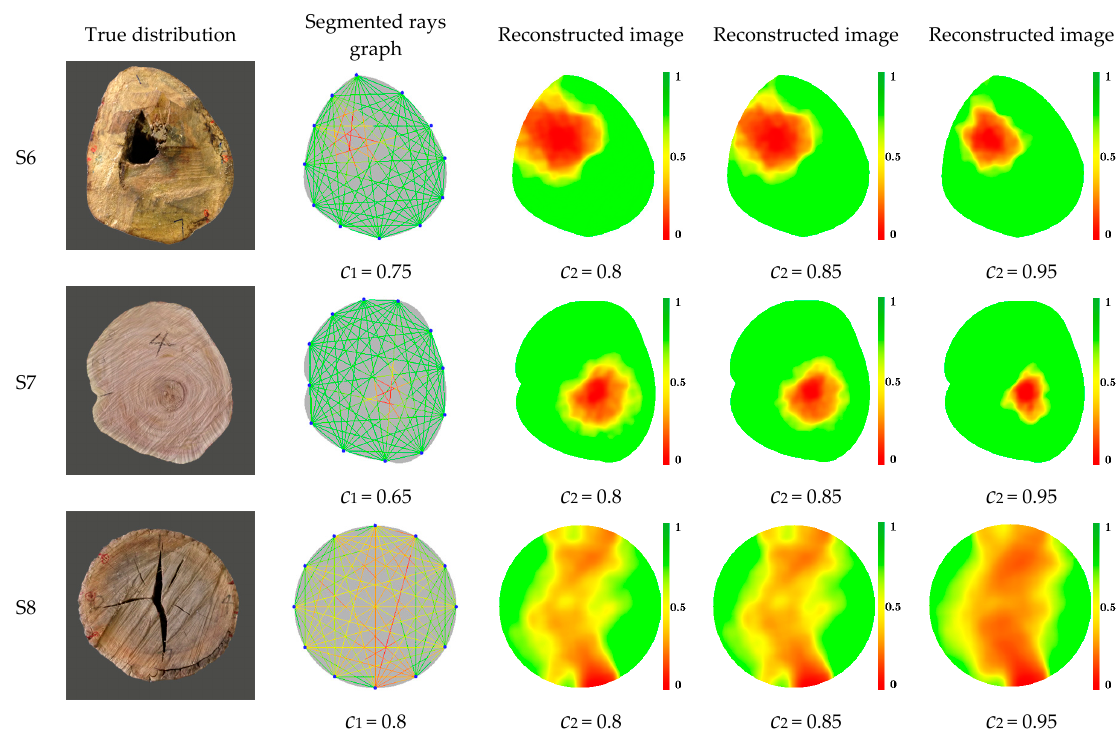
Figure 8. Original rays graph and segmented rays graph using the RSEN method from the real data with different control coefficients.